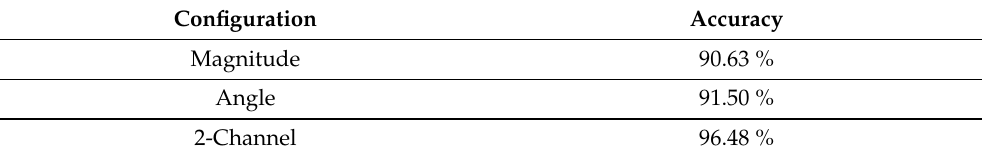
Table 5. CSI approach accuracy for magnitude angle and two-channel